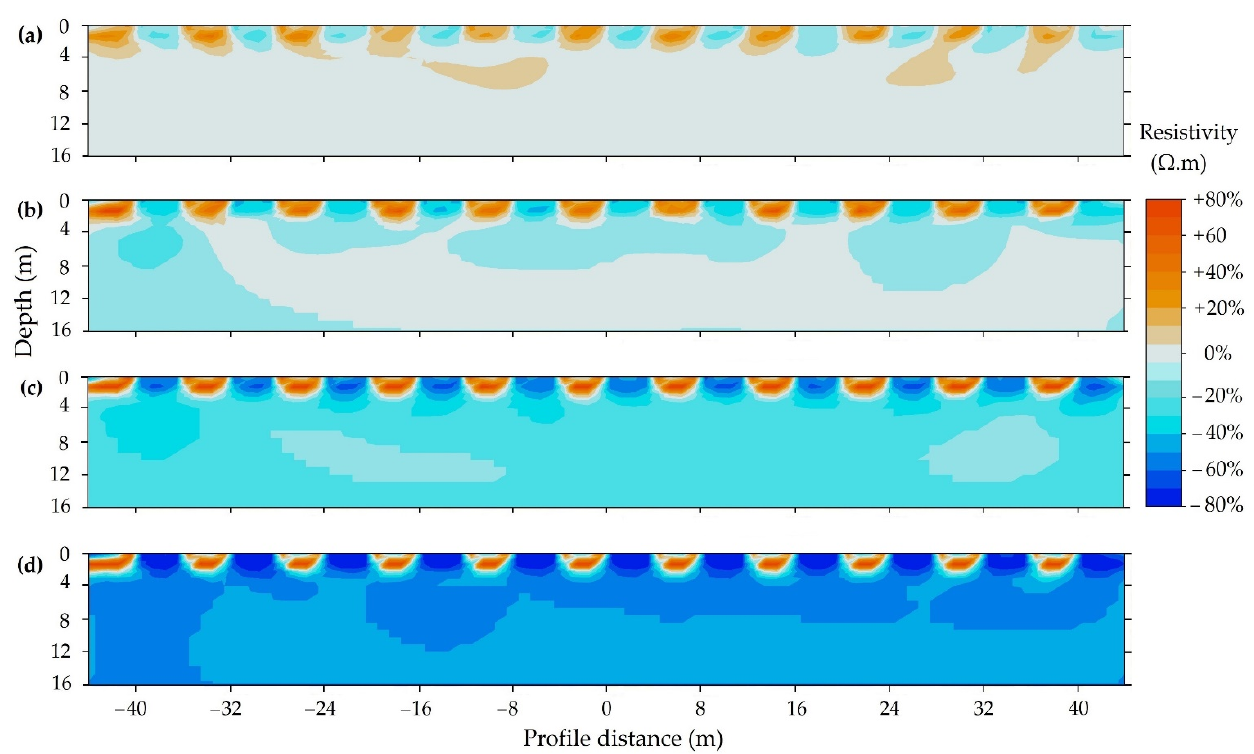
Figure 28. Wenner–Schlumberger (WS) array sensitivity to resistivity perturbations. The inverted model for: ( a ) ±20%